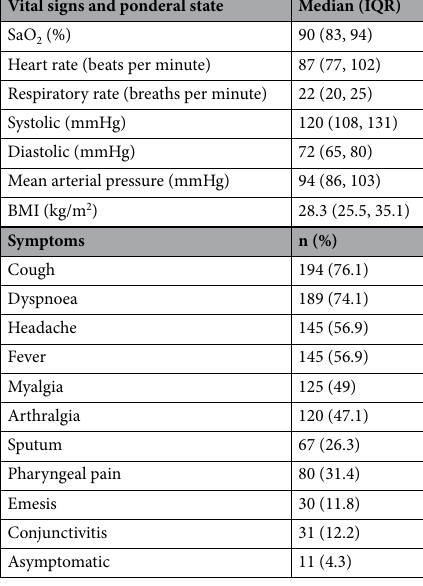
Table 1. Signs and symptoms.